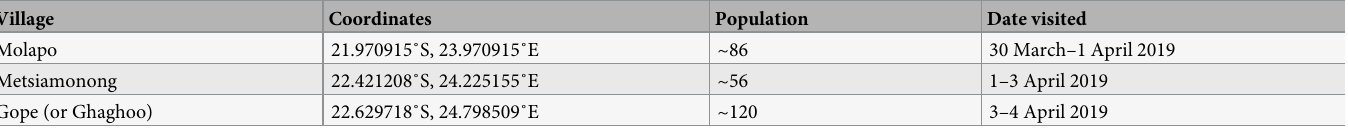
Table 1. G/ui and G//ana San communities (villages) in the CKGR visited for this study. Village